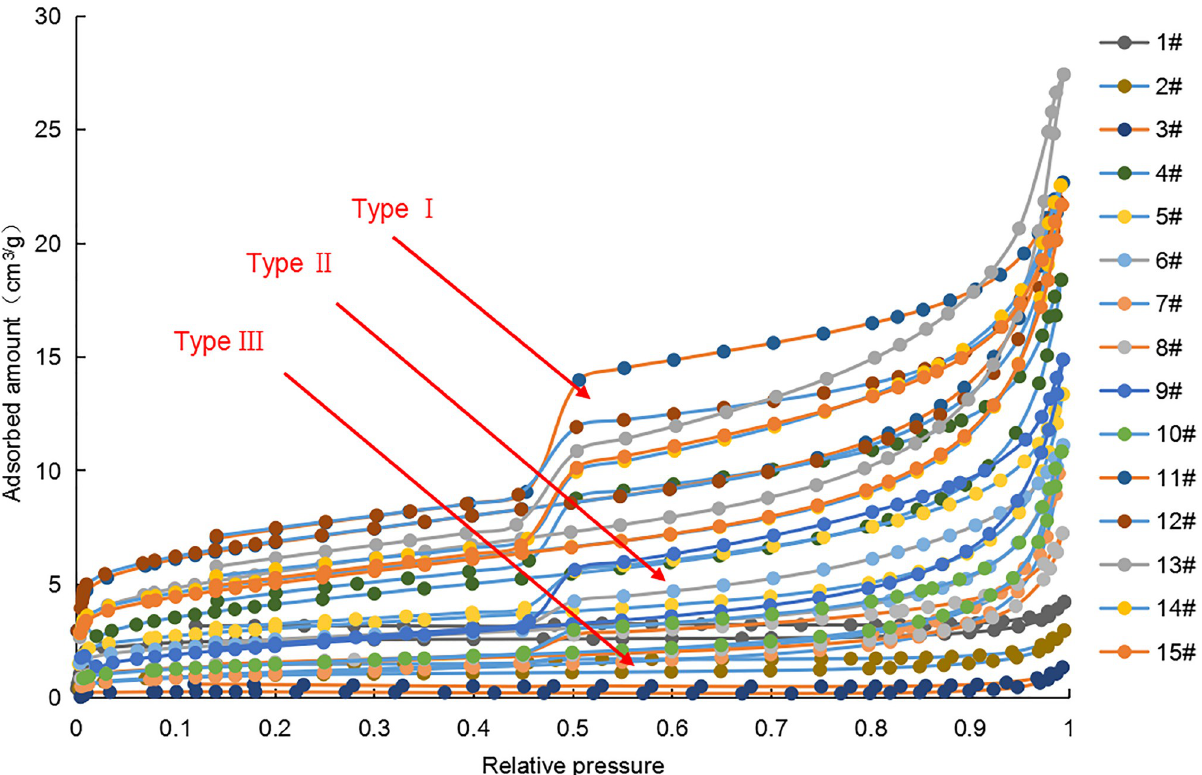
Fig 8. Isotherm adsorption and desorption curves for different samples using low-temperature nitrogen.